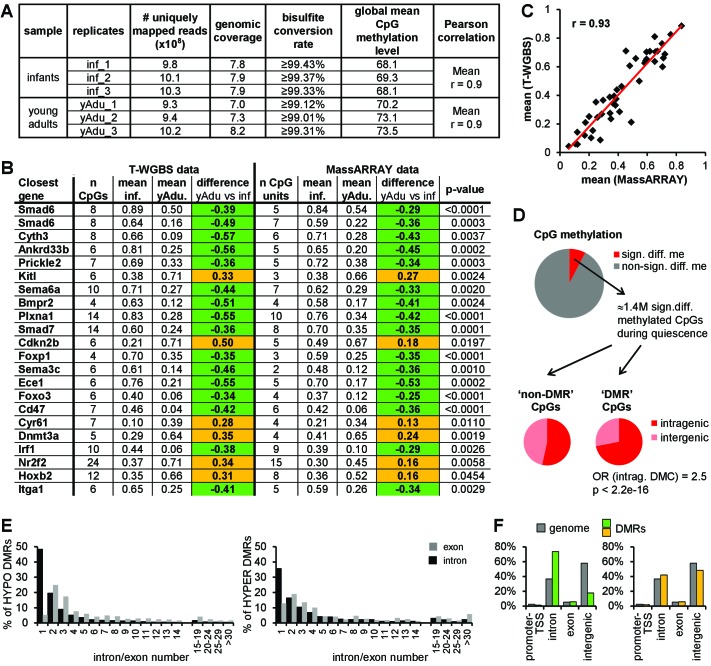
DNA methylation profiling of lung EC during transition to vascular quiescence.(A) Tagmentation-based WGBS data QC. (B) Validation of 22 DMRs identified by T-WGBS by MassARRAY. The difference in methylation is highlighted in green (loss of methylation during vessel maturation) or orange (gain of methylation during vessel maturation). (C) Correlation of mean methylation per region of T-WGBS and MassARRAY data. (D) Genomic distribution of differentially methylated CpGs external (’non-DMR’ CpGs) and within (‘DMR’ CpGs) DMRs. OR = odds ratio, Fisher's Exact Test. (E) Detailed analysis of intragenic DMRs concerning exon/intron location. (F) Distribution of the loss (green) and gain (yellow) of methylation DMRs compared to the genomic distribution.